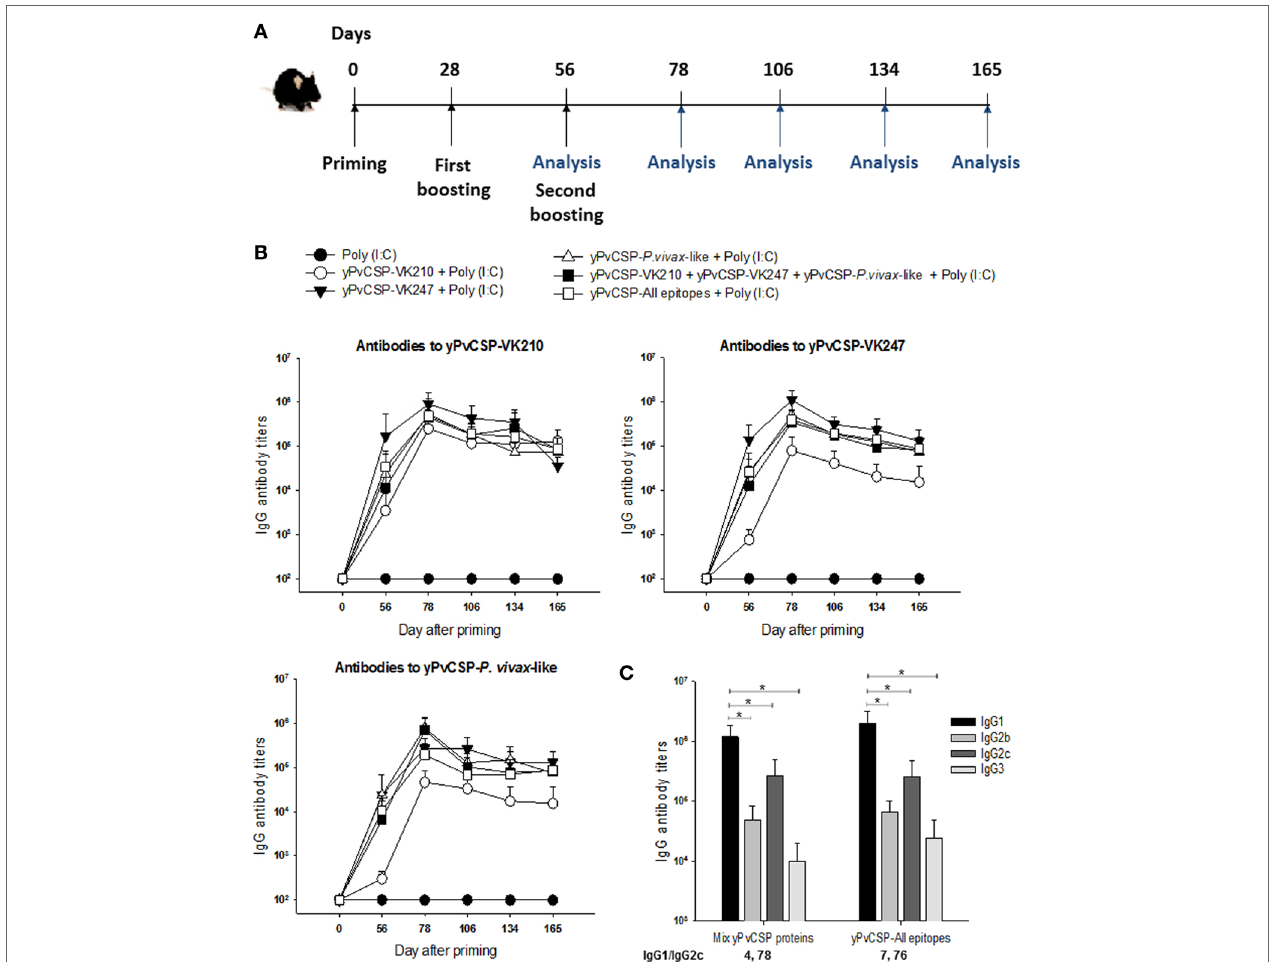
FigUre 3 | Specific antibody response in mice immunized with Plasmodium vivax circumsporozoite protein (PvCSP) recombinants. (a) C57BL/6 mice were immunized s.c. with three doses 28 days apart with the purified proteins in the presence of the adjuvant Poly(I:C), whereby the antibody response was analyzed according to the timeline described. (B) The IgG antibody serum titers against recombinant proteins representing each allelic form of PvCSP were analyzed by ELISA. The results are expressed as the means ± SD ( n = 6). Mouse groups were immunized with: (1) Poly(I:C); (2) Poly(I:C) plus yPvCSP-VK210 (1 μ g/dose/mouse); (3) Poly(I:C) plus yPvCSP-VK247 (1 μ g/dose/mouse); (4) Poly(I:C) plus yPvCSP- P. vivax -like (1 μ g/dose/mouse); (5) Poly(I:C) plus a protein mix [yPvCSP-VK210 (1 μ g/dose/mouse) + yPvCSP-VK247 (1 μ g/dose/mouse) + yPvCSP- P. vivax -like (1 μ g/dose/mouse)]; or (6) Poly(I:C) plus yPvCSP-All epitopes (3 μ g/dose/mouse). (c) IgG isotypes were determined by ELISA in sera of mice from groups 5 and 6 described above. Asterisk denotes statistical differences (